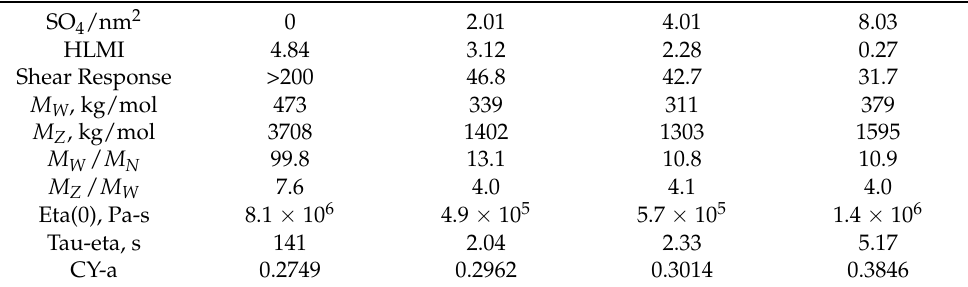
Table 3. Response of Cr/alumina with rising sulfate